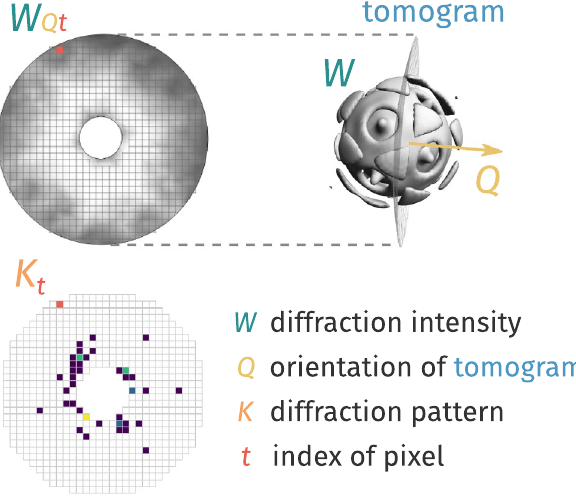
Figure 1. Schematic of how orientations are encoded in XFEL-SPI. A diffraction pattern collected on a detector ( K t where t labels the pixels on the detector) of a scatterer is an Ewald tomogram W Qt through the 3D diffraction volume W . When this scatterer suffers an active random 3D rotation (cid:31) about its own original reference frame, it is equivalent to a passive rotation of said Ewald tomogram in the opposite sense (i.e. (cid:31) − 1 ). Throughout the rest of the paper, we parametrize this rotation with unit quaternions Q ≡ �( Q ) (primer on unit quaternions in Supplementary